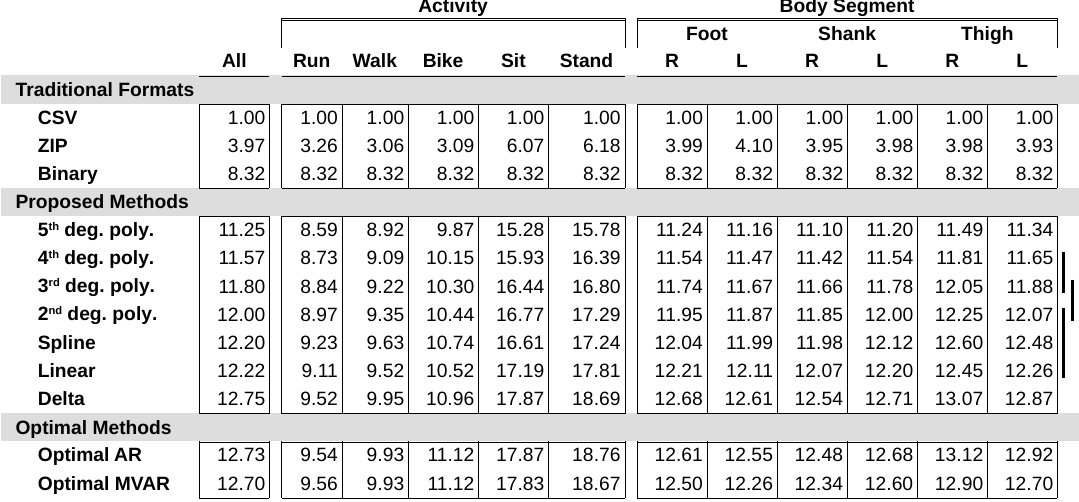
Figure 4. Compression ratios for all methods across movement activity and body segment. Groups of data classes and methods without significantly different compression ( p ≥ 0.05) are indicated by bars below and to the right of the table respectively. Specifically, horizontal bars represent statistical analysis of the delta compression method applied to each data class, while vertical bars represent statistical analysis of each proposed method applied to all data.